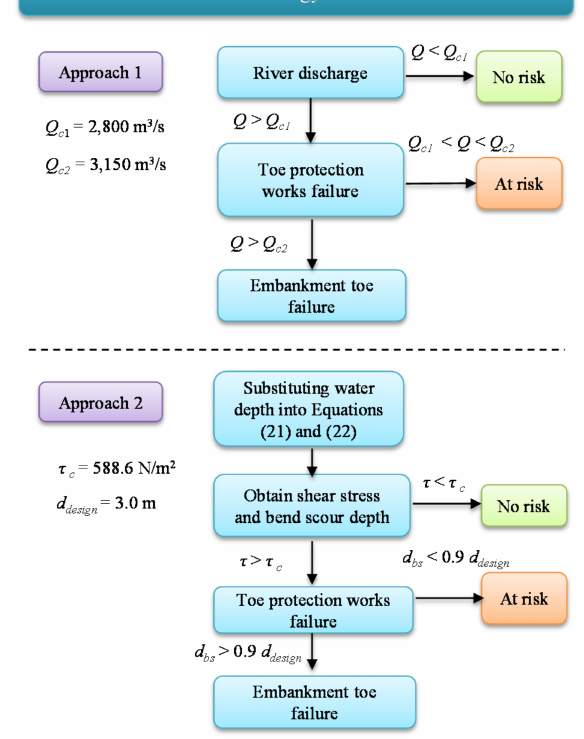
Figure 15. Procedure of the proposed assessment methodology for predicting reinforced concrete embankment